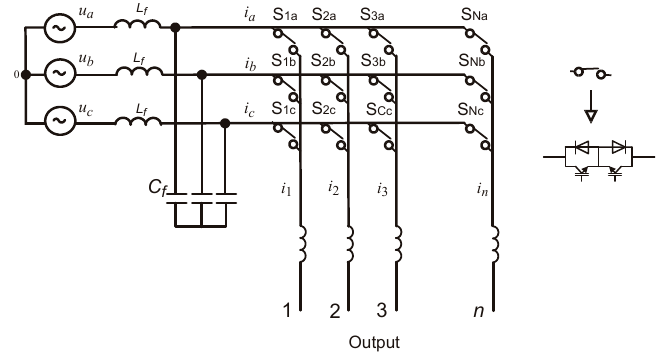
Figure 1. The scheme of the 3-phase input n -phase output MC.